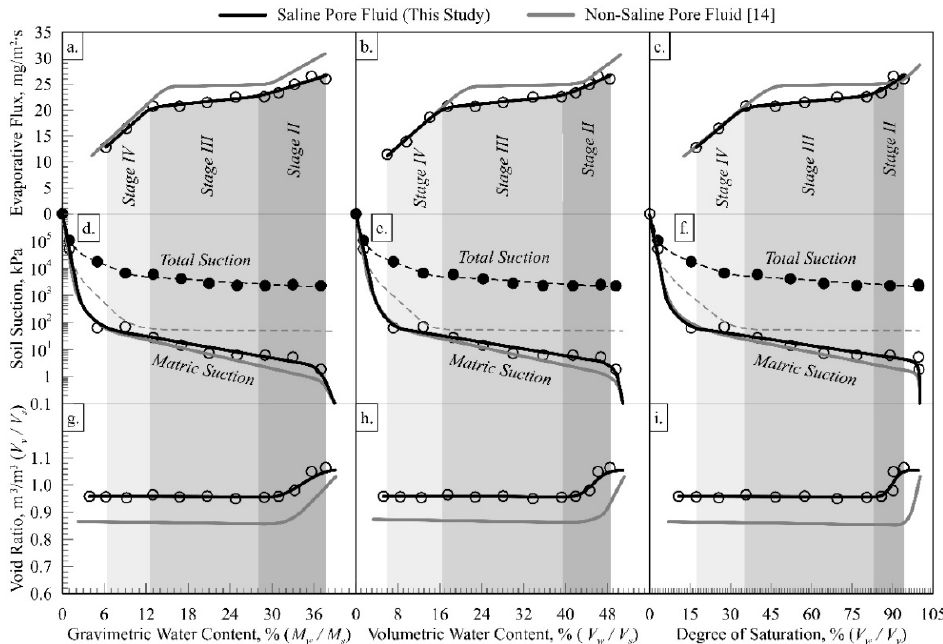
Figure 3. Behavior of silty sand under low atmospheric demand: ( a ) w -based evaporative flux; ( b ) θ -based evaporative flux; ( c ) S -based evaporative flux; ( d ) w -based water retention curve; ( e ) θ -based water retention curve; ( f ) S -based water retention curve; ( g ) w -based soil shrinkage curve; ( h ) θ -based soil shrinkage curve; and ( i ) S -based soil shrinkage